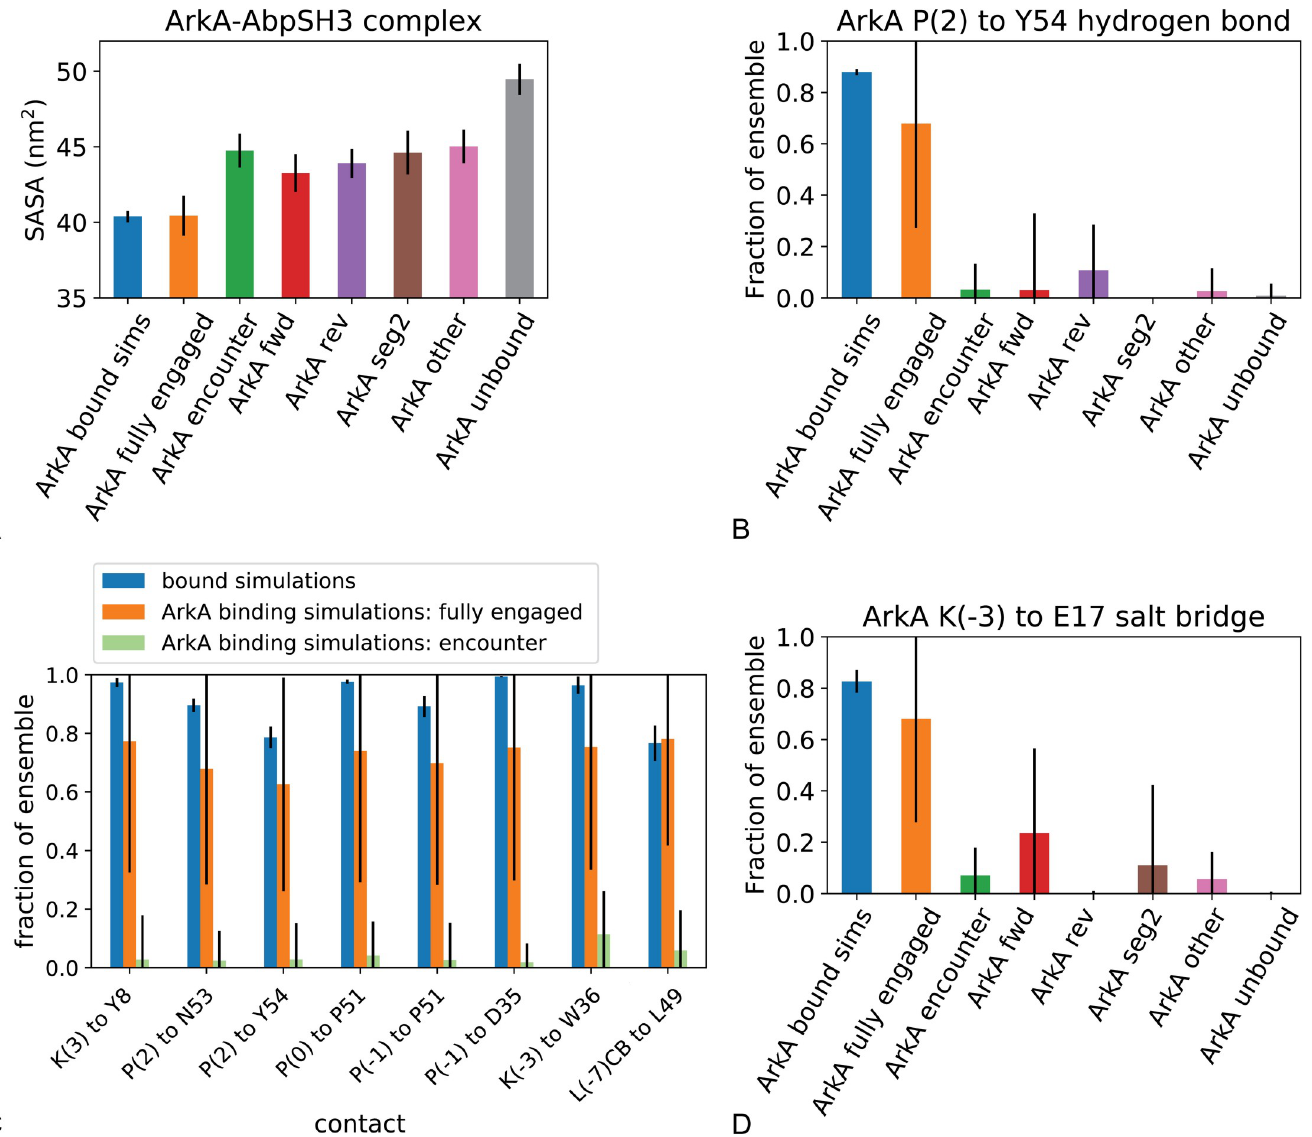
Fig 10. Solvent accessibility and specific intermolecular interactions for ArkA-AbpSH3 complex. A) Average solvent accessible surface area (SASA) of the ArkA-AbpSH3 system in the bound simulations (first bar) and binding simulations, by state of the complex. B) Occupancy of the P(2) to Y54 hydrogen bond in the bound simulations and ArkA binding simulations by state of the complex. C) Specific hydrophobic contacts between ArkA and the AbpSH3 binding surface in the fully engaged state and the encounter complex. D) Occupancy of the K(-3) to E17 salt bridge in the bound simulations and ArkA binding simulations by state of the complex. Error bars represent the standard deviation between independent